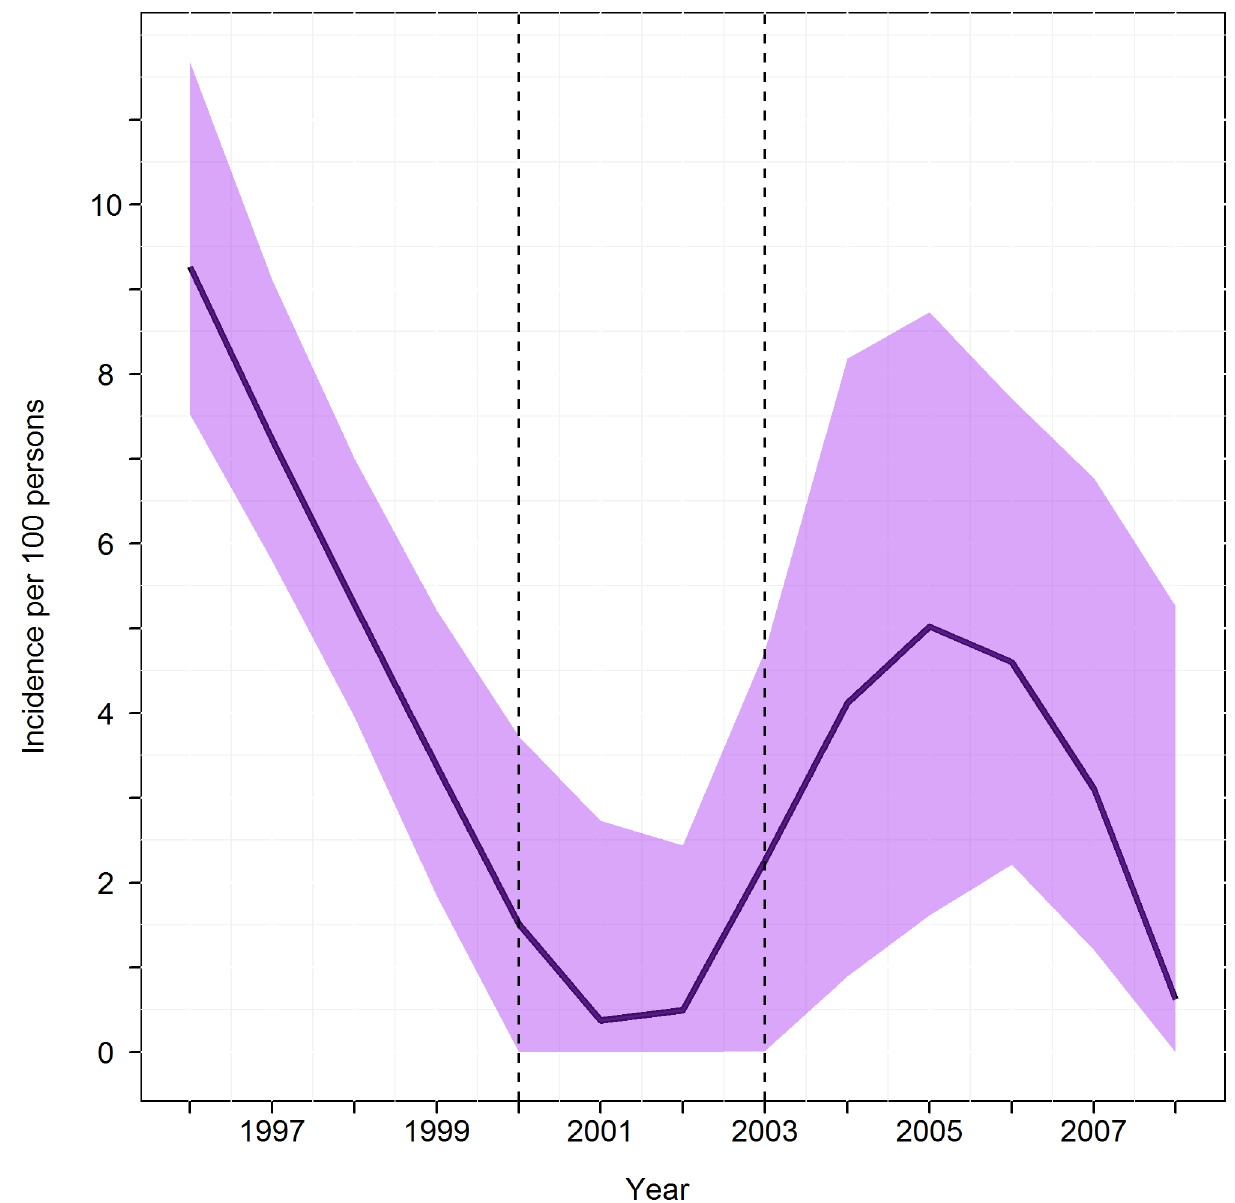
Figure 3. Estimated incidence calculated from the catalytic model. Shaded regions around the line are the 95% confidence intervals of model to data points. Vertical dash lines indicate the knots corresponding to the years of blanket spray